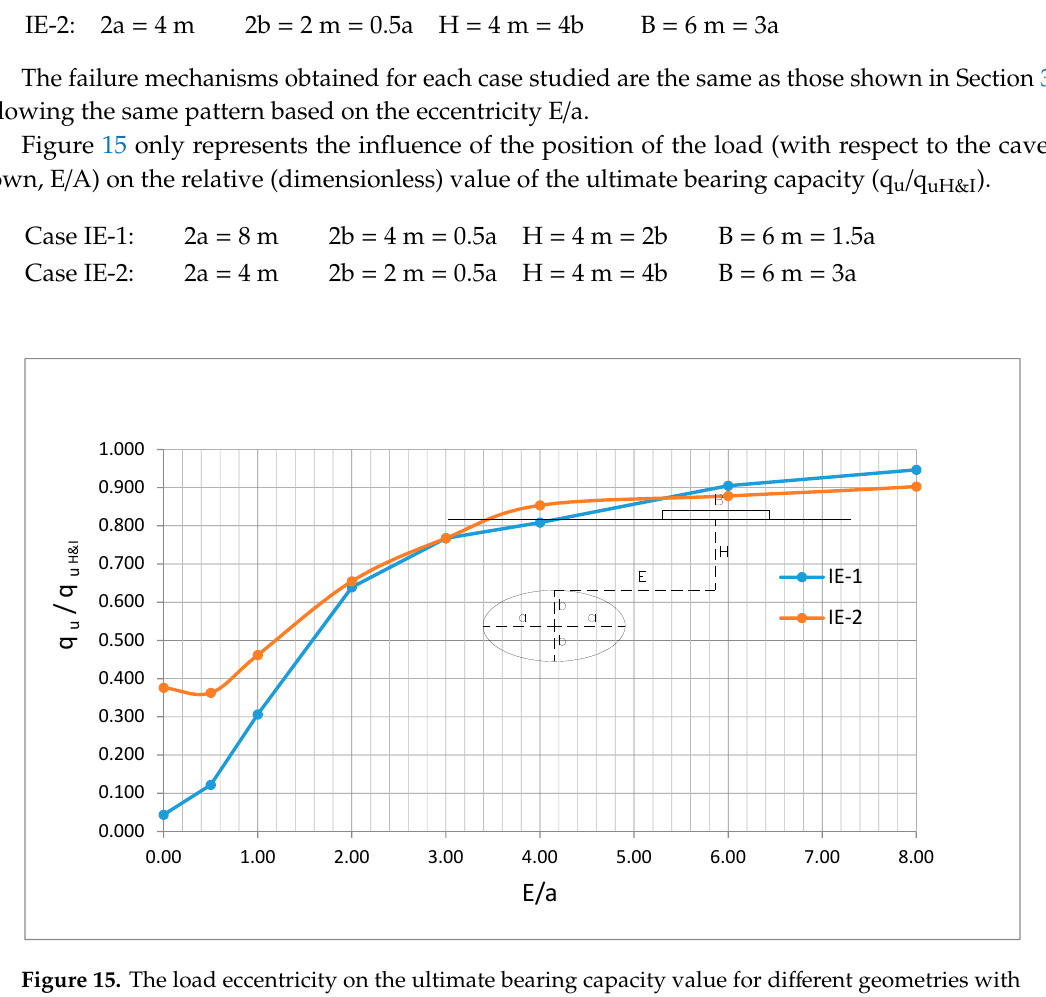
Figure 15. The load eccentricity on the ultimate bearing capacity value for different geometries with respect to the footing width.